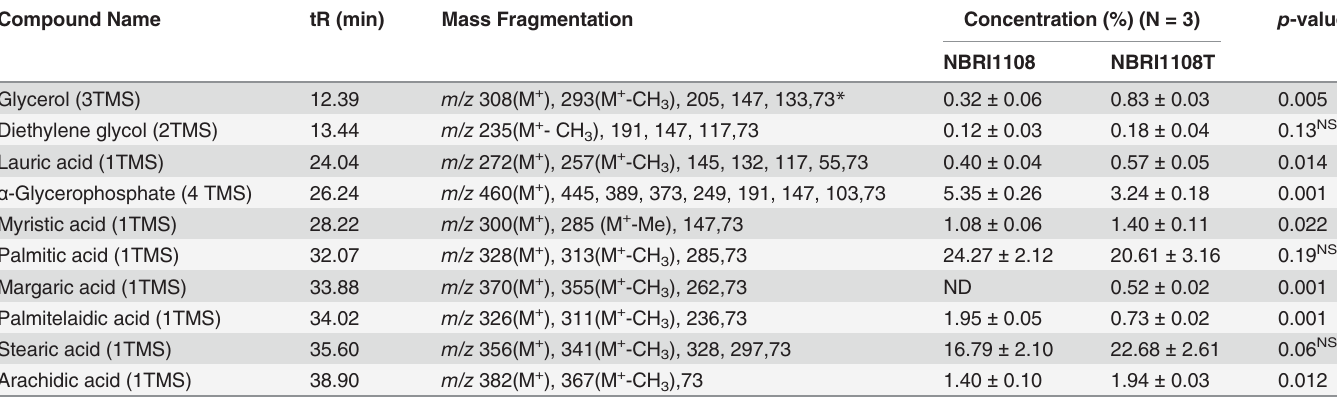
Table 2. Qualitative and quantitative assignments of CHCl 3 : MeOH (2:1) soluble metabolites identi fi ed by GC-MS in the extract of P. putida NBRI1108 and NBRI1108T. Compound